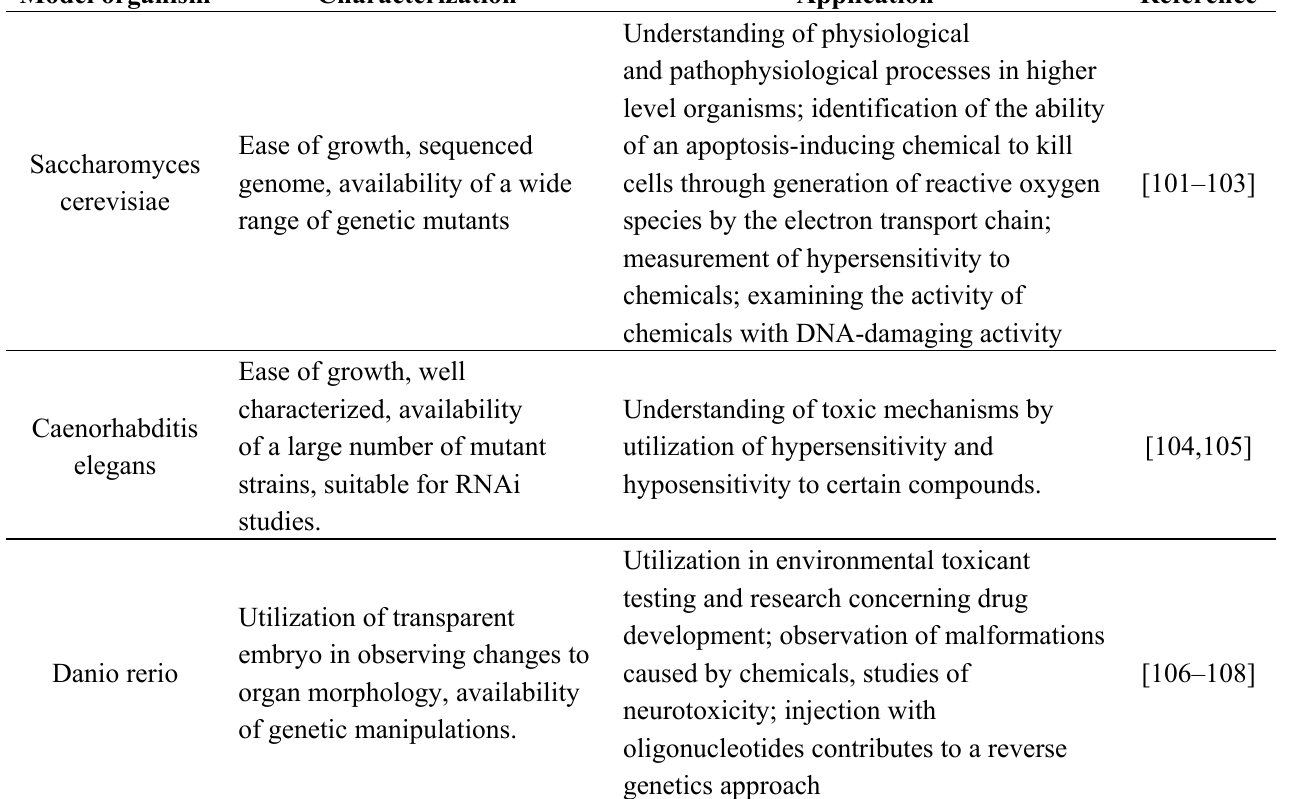
Table 4. Model organisms used in High-throughput screening